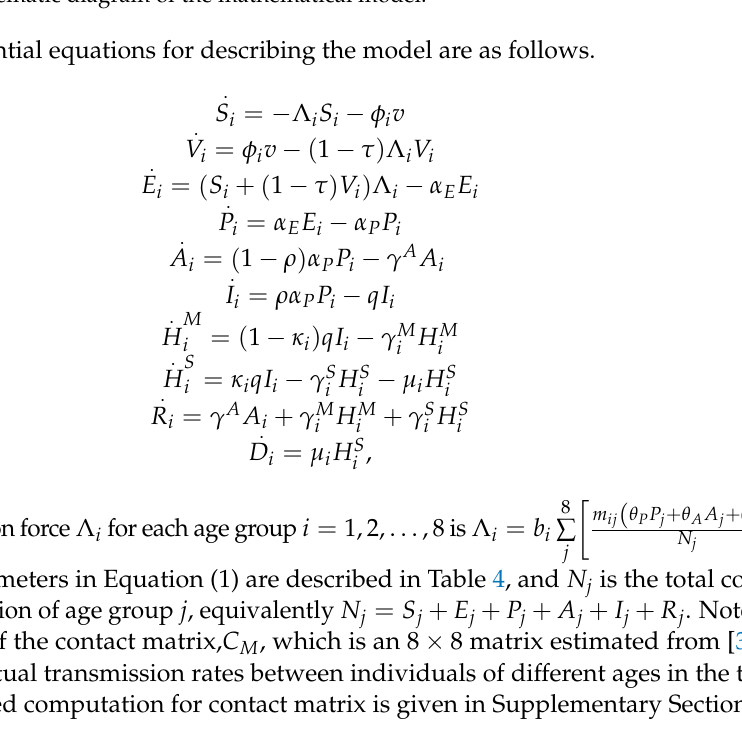
Figure 2. Schematic diagram of the mathematical